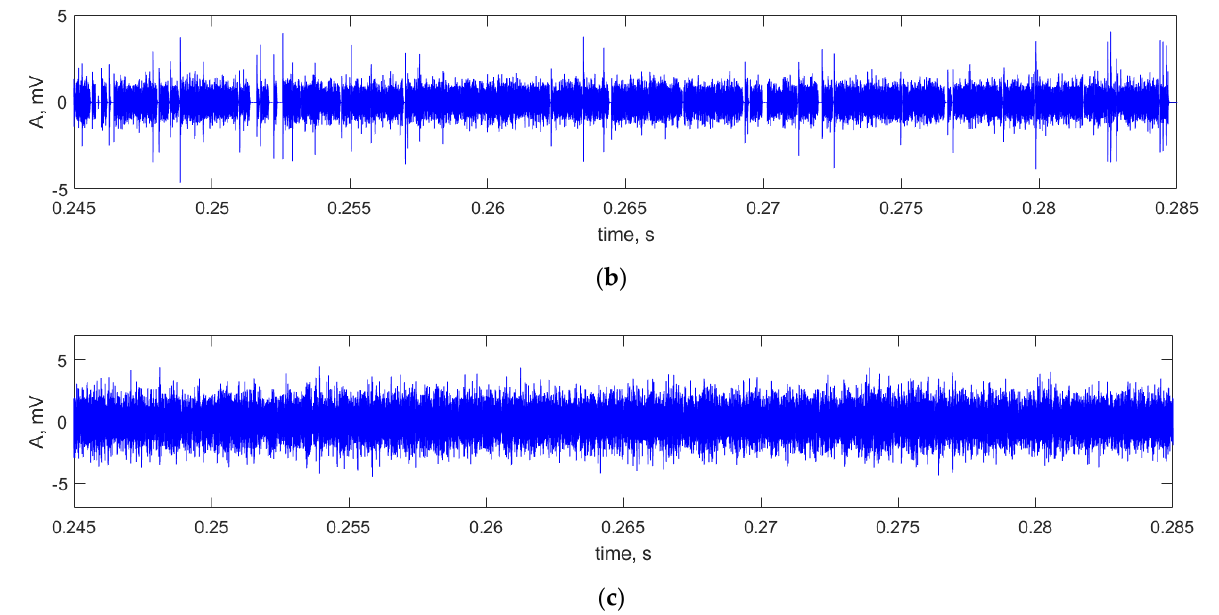
Figure 8. Characteristic background acoustic signals: the single arrival of Type 1 pulses with random intervals ( a ), the signal corresponding to the arrival of Type 2 signals with random intervals ( b ), the combination of both signals ( c ).